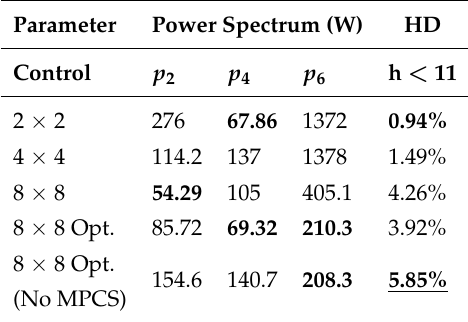
Figure 10. Steady-state analysis of each configuration by means of: ( a ) FFT of measured power at the point of common coupling (PCC); ( b ) FFT of the three-phase current at the PCC (Zoom in low values). Table 5. Experimental